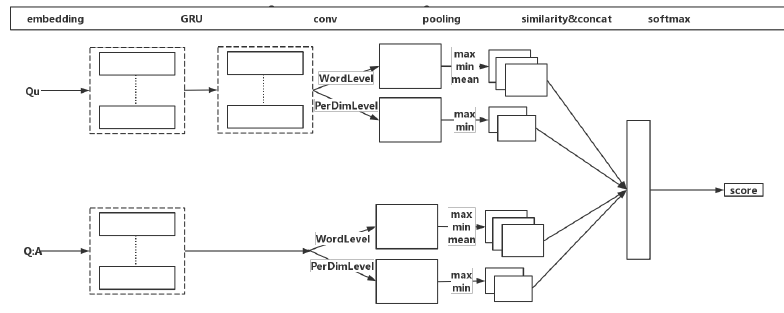
Figure 4. Multi-perspective sentence similarity network with gated recurrent unit (GRU).